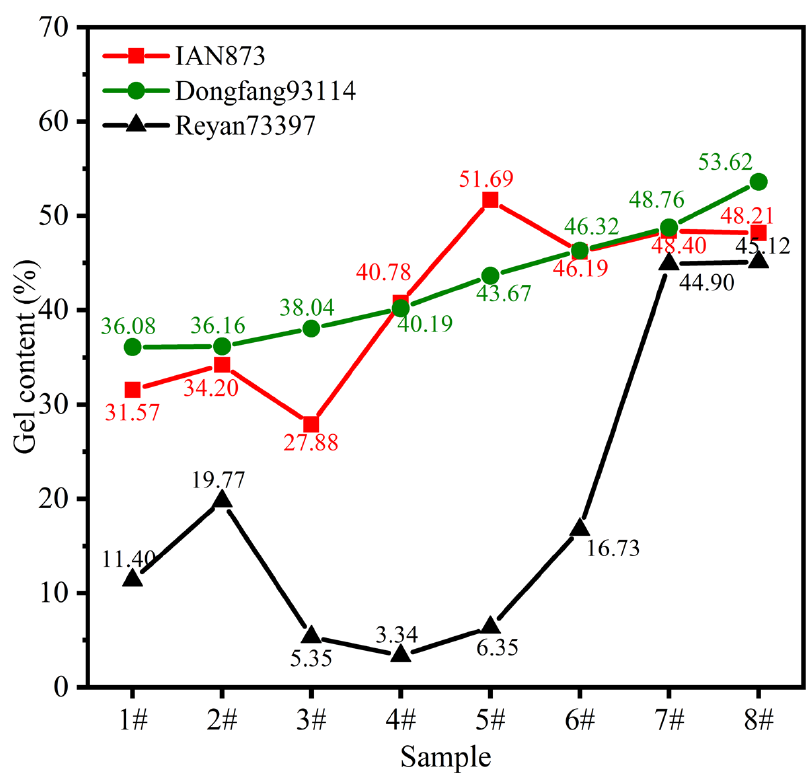
Figure 5. Gel content of rubber films obtained from separated latexes of different Hevea brasiliensis clones. with corresponding